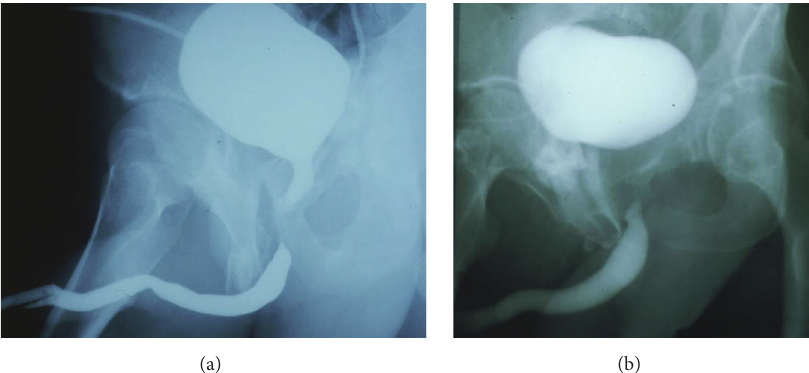
Figure 2: (a) After the bladder is filled with contrast through the suprapubic tube, a RUG is performed as the patient is asked to attempt to void. If the bladder neck opens, contrast fills the prostatic urethra, and the membranous urethral defect is seen. (b) When the bladder neck does not open, the length of the defect cannot be determined accurately.